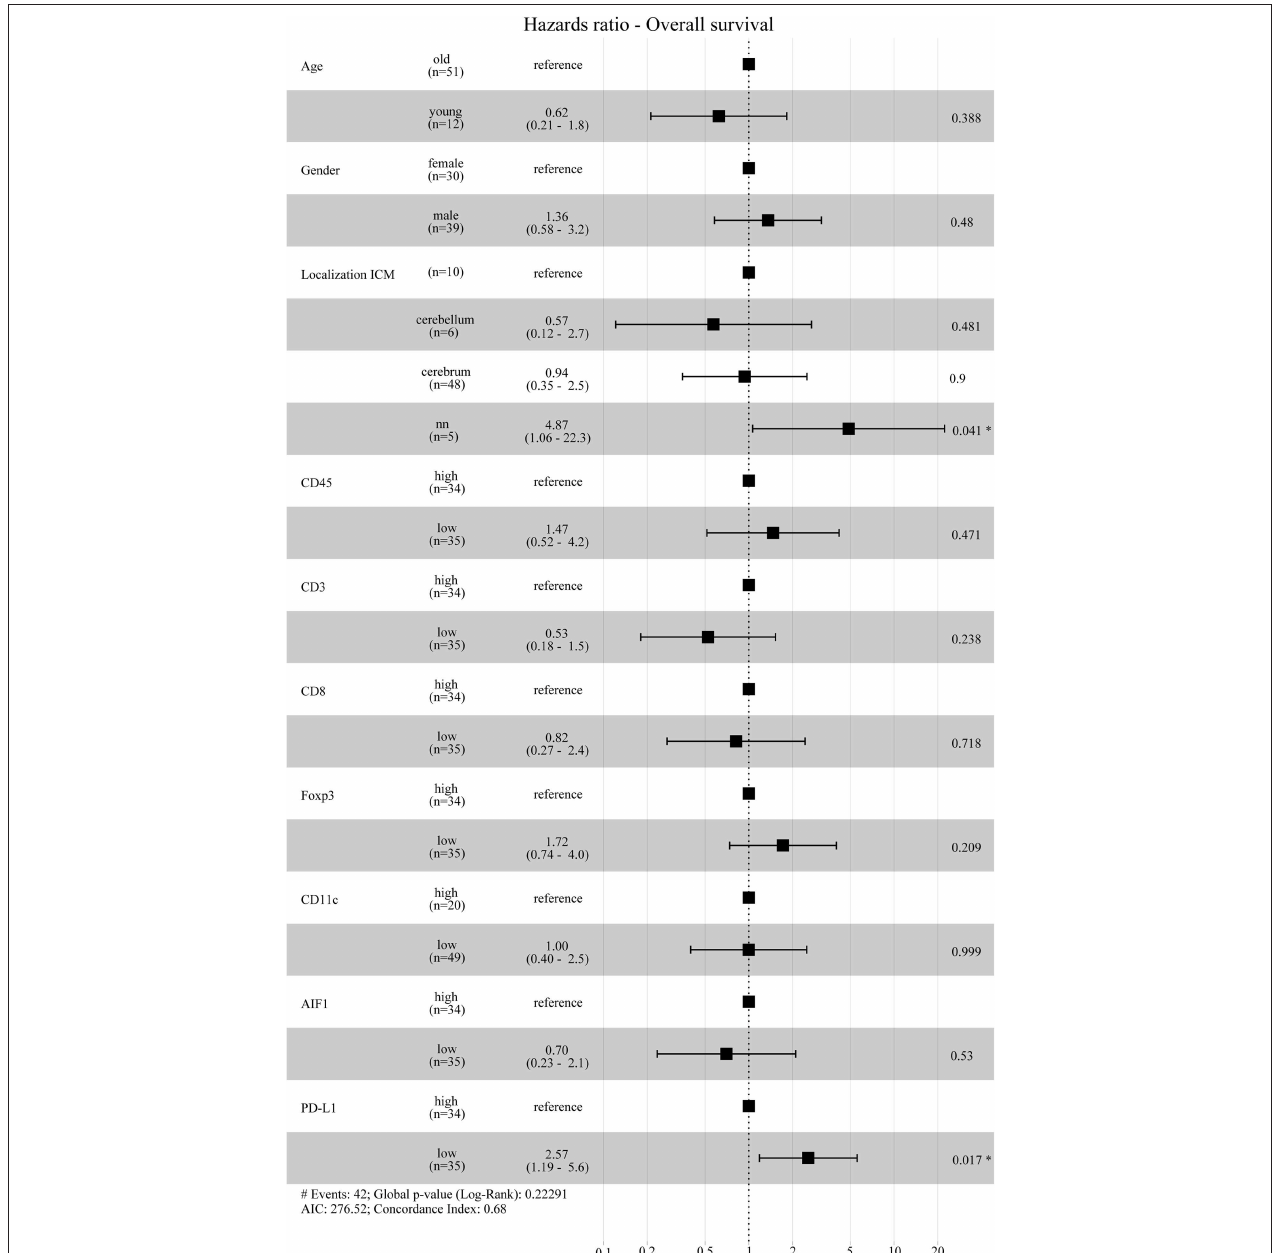
FIGURE 6 | Hazard ratio Overall survival. Forest plot for the cox proportional hazards model was calculated by using age, gender, localization of the ICM and immunoreactive infiltrates. The patients below 40 years of age at death were grouped in the “young” group and vice versa. For the immune cell infiltrates the patients were grouped into a “high” or “low-group” based on the median expression values. According to the multivariate model, low PD-L1 expressing patients have a significantly higher hazards ratio and thus poor overall survival compared to patients with high PD-L1